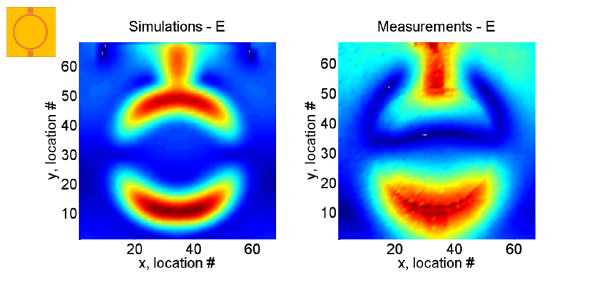
Figure 8: | E z | magnitude of the E-field for simulations (CST (cid:114) , left) and measurements (right) in the vicinity of the empty ring resonator at f = 2 . 66